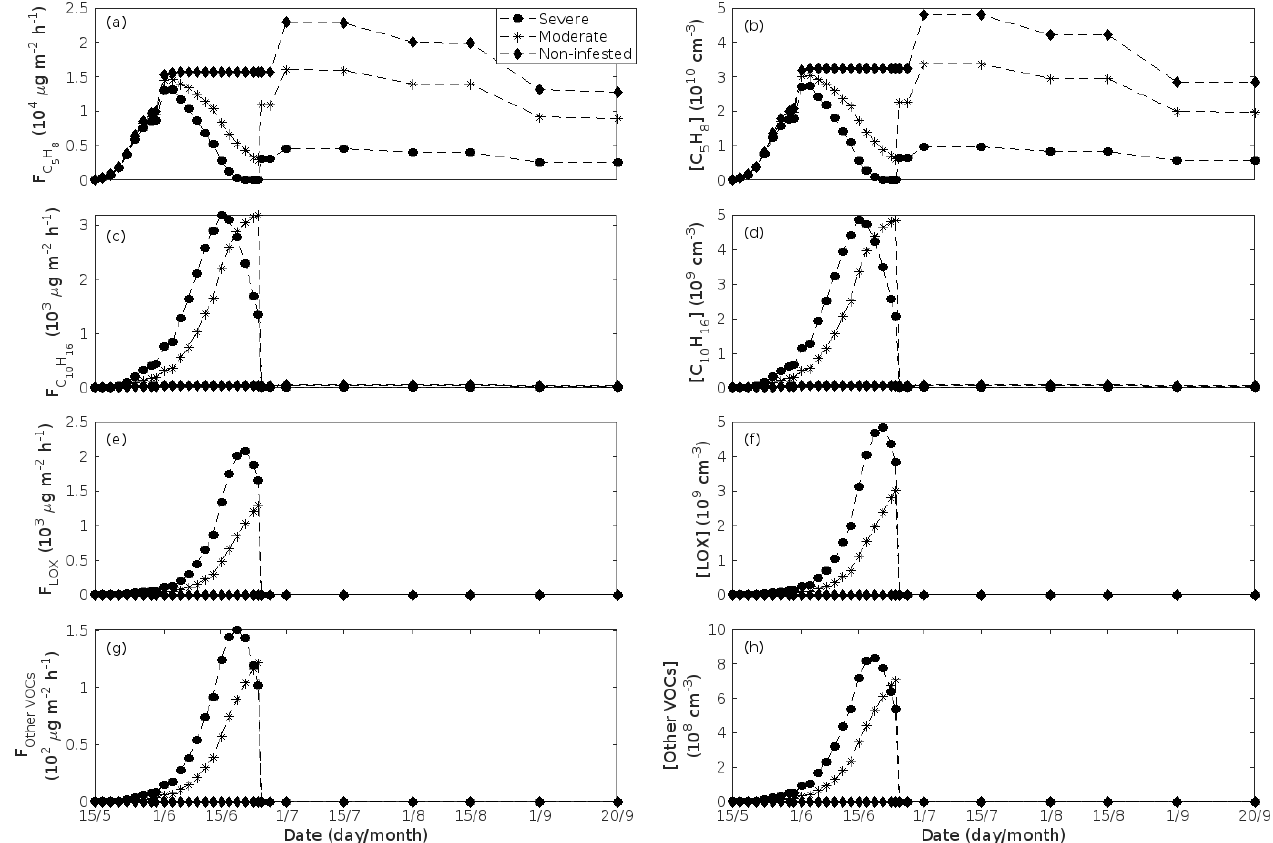
Figure 5. A pure oak stand infested with European gypsy moth larvae in comparison to a non-infested pure oak stand. Canopy emissions of (a) isoprene, (c) monoterpenes, (e) lipoxygenase pathway volatiles (LOX), and (g) the sum of other VOCs that contribute to OxOrg formation (i.e. methyl salicylate and dimethyl-nonatriene). Atmospheric concentrations of (b) isoprene, (d) monoterpenes, (f) lipoxygenase pathway volatiles, and (h) the sum of other VOCs which contribute to OxOrg formation. “Moderately” and “severely” refer to 30% and 80%, respectively, of the leaf area that has been consumed by the end of the feeding